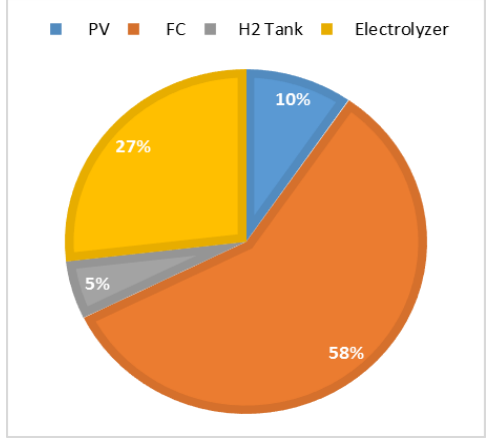
Fig. 7: The breakdown of the TNPC of the optimum HPBRS components